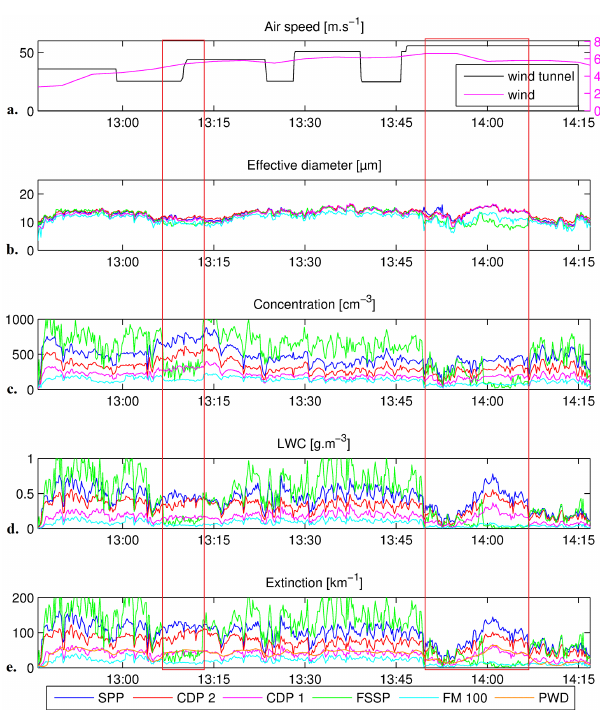
Figure 2. Time series of the 16 May experiment of the main mea- sured parameters: (a) ambient wind speed (purple) and wind tun- nel air speed (black); (b) effective diameter; (c) concentration; (d) LWC and (e) extinction. The data are 10s averaged, except for the PWD measurements performed with a 1min time resolution. The red-framed parts of the time series correspond to additional exper- iments where the orientation of the instruments on the mast was changed (for the FM-100 and the